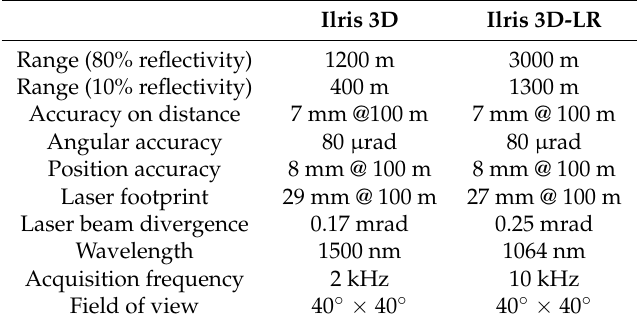
Table 1. Technical overview of the terrestrial laser scanners used in the study (from the Optech R (cid:13) factsheets). Ilris 3D Ilris 3D-LR Range (80% reflectivity) 1200 m 3000 m Range (10% reflectivity) 400 m 1300 m Accuracy on distance 7 mm @100 m 7 mm @ 100 m Angular accuracy 80 µ rad 80 µ rad Position accuracy 8 mm @ 100 m 8 mm @ 100 m Laser footprint 29 mm @ 100 m 27 mm @ 100 m Laser beam divergence 0.17 mrad 0.25 mrad Wavelength 1500 nm 1064 nm Acquisition frequency 2 kHz 10 kHz Field of view 40 ◦ × 40 ◦ 40 ◦ × 40